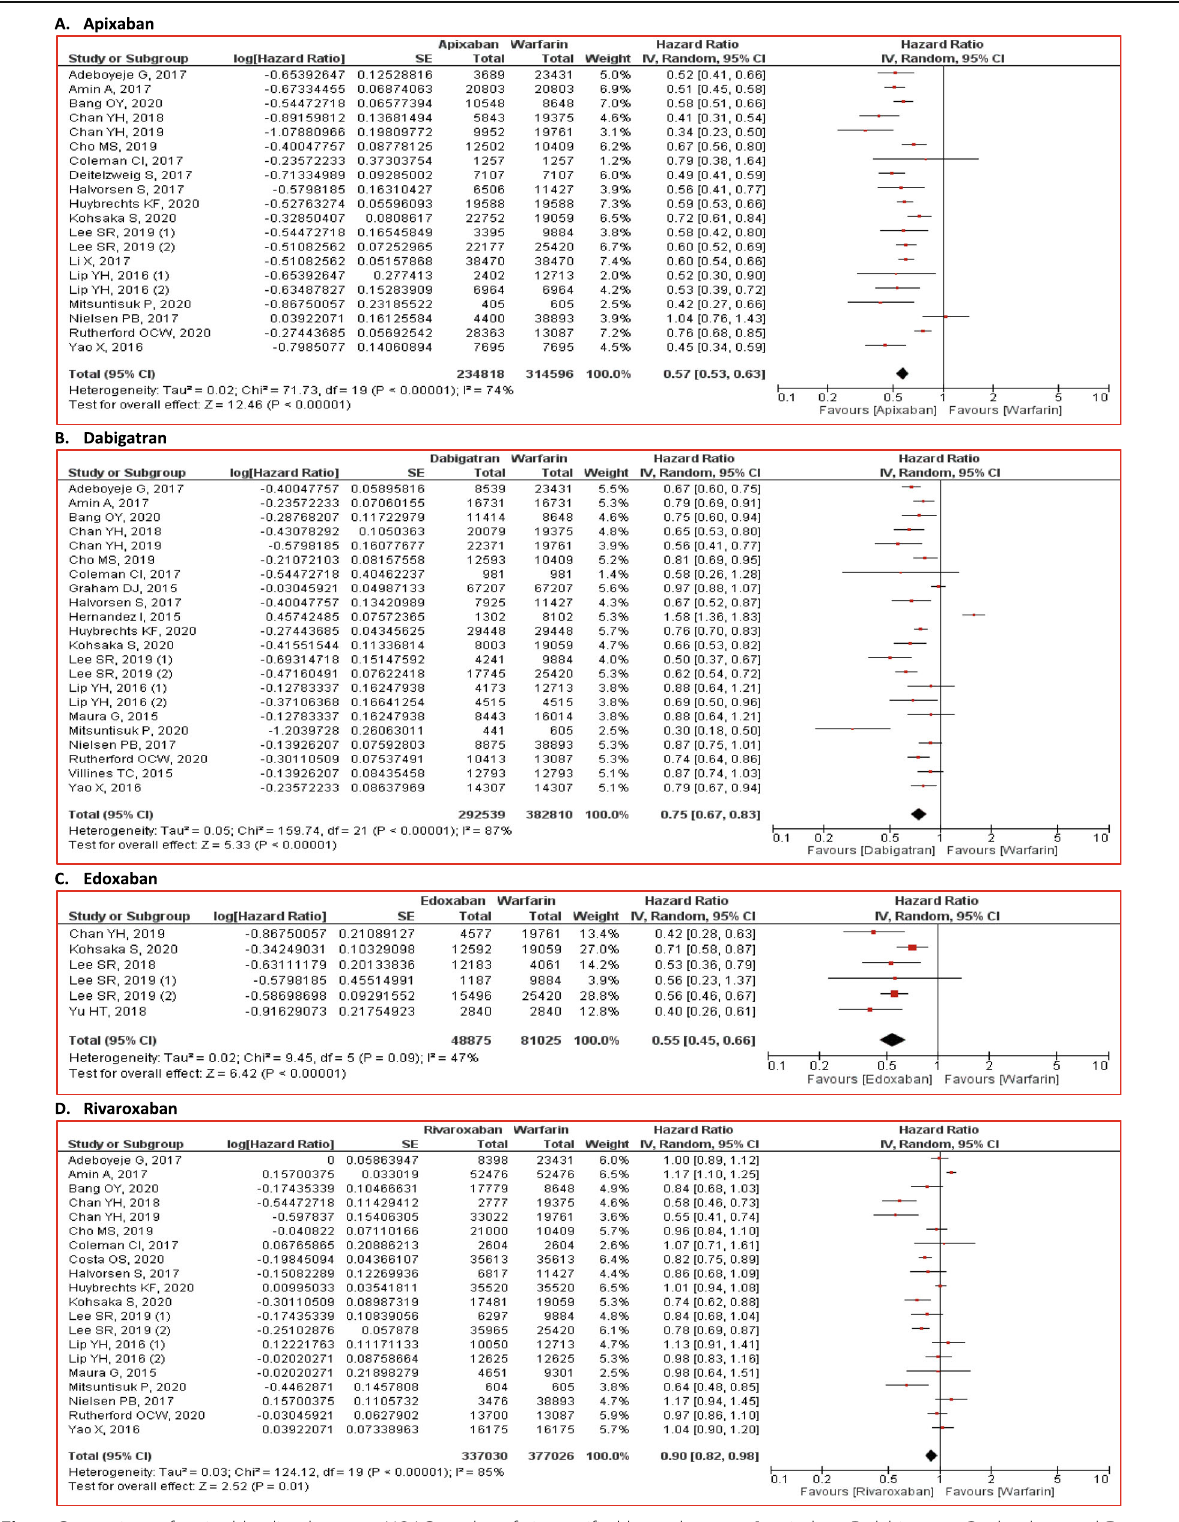
Fig. 5 Comparison of major bleeding between NOACs and warfarin stratified by each agent. A apixaban, B dabigatran, C edoxaban, and D rivaroxaban. CI = confidence interval, NOACs = non-vitamin K antagonist oral